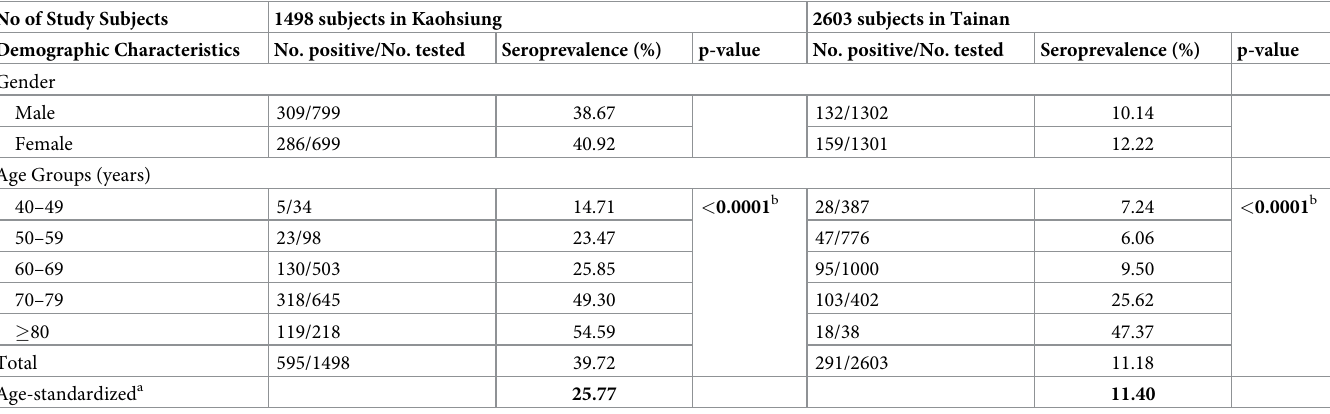
Table 1. Age-, gender-, and district-specific seroprevalence of anti-DENV IgG in Kaohsiung City and Tainan City in